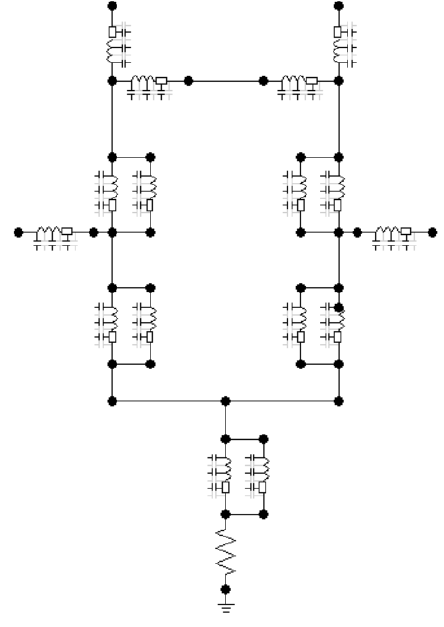
Figure 1. Multi-wave impedance model.